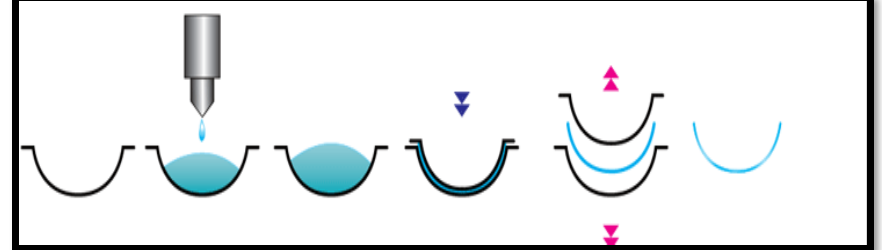
Fig. 1. Making contact